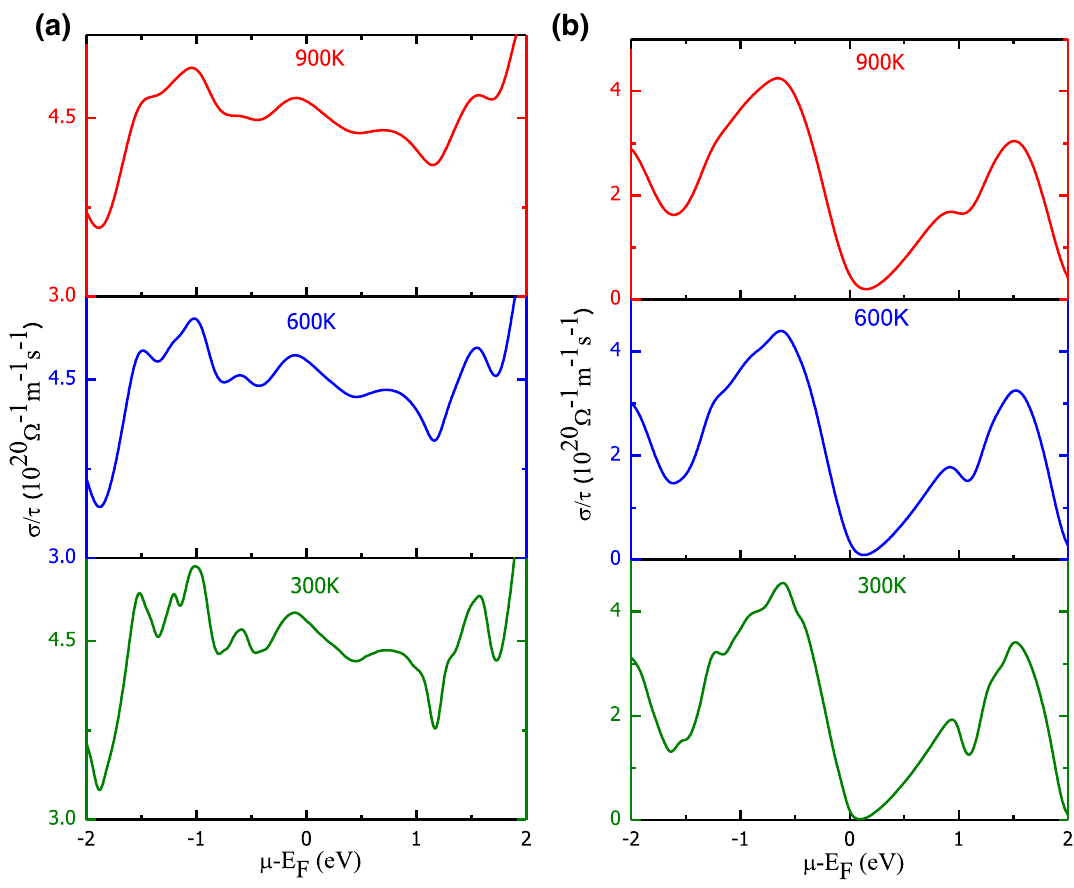
Figure 8. Variation in total electronic conductivity coefficient over relaxation time against chemical potential and temperature: ( a ) Ba 2 FeNiO 6 ; ( b ) Ba 2 CoNiO 6